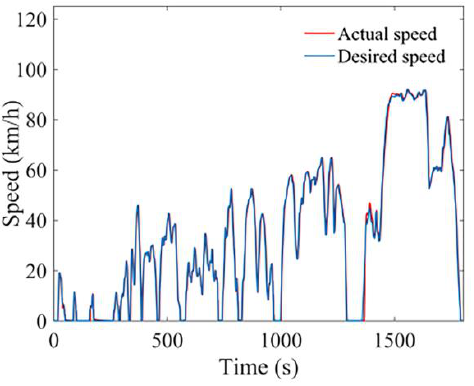
Figure 15. Speed following situation.